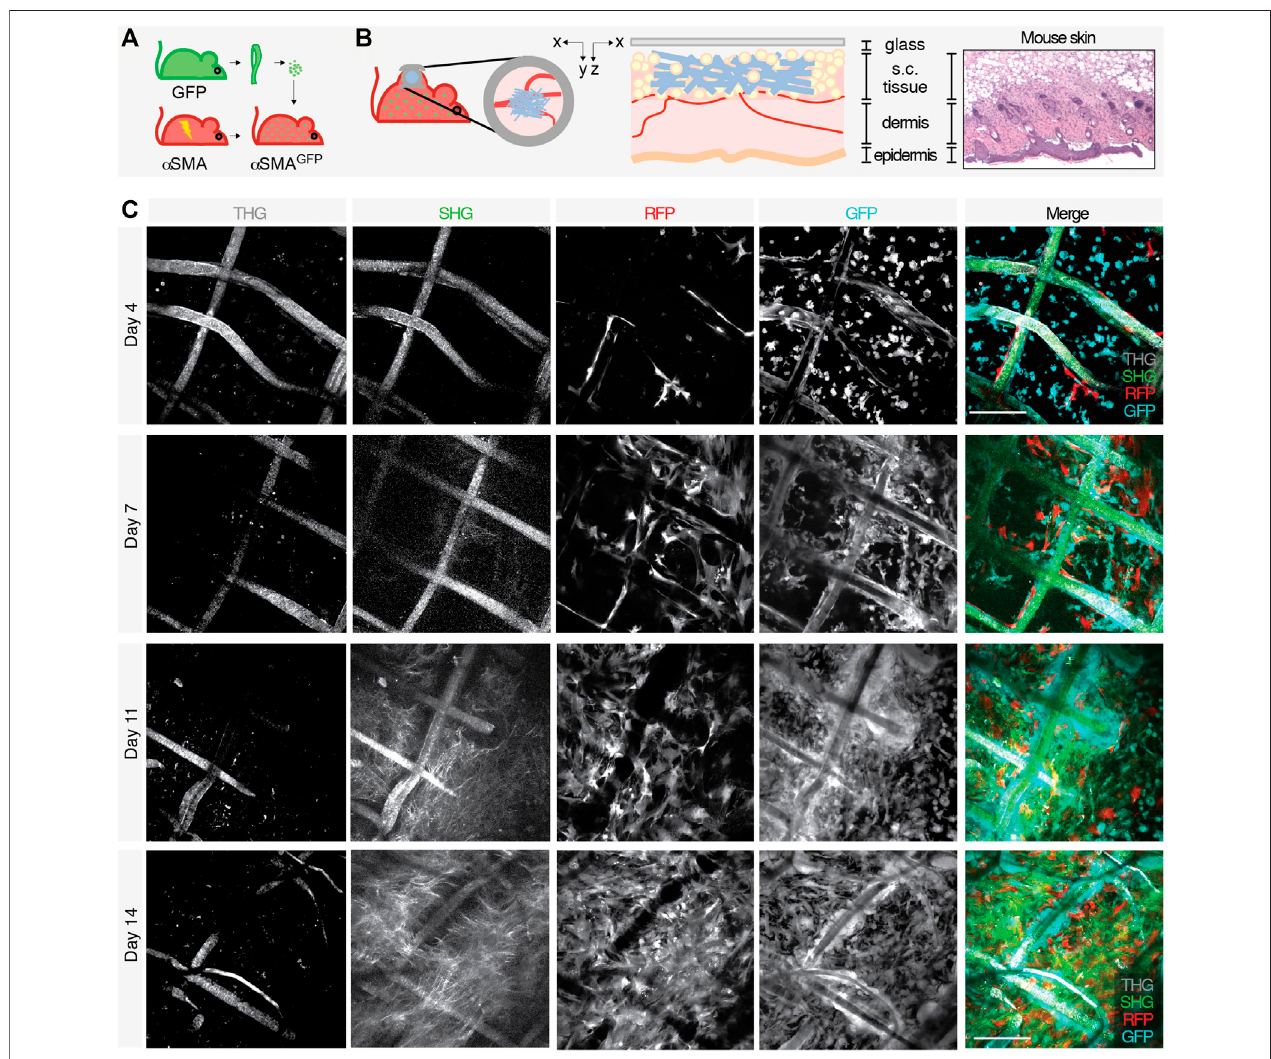
FIGURE2 | Generation ofan in vivo model to study the FBR and acquisition ofimages bylongitudinal intravital multiphoton microscopy. Schematic representation of the model showing (A) the bone marrow transplant in lethally irradiated α SMA-RFP mice reconstituted with GFP bone-derived cells to generate an α SMA-RFP/GFP mouse and (B) scaffold implantation inside the DSFC within the subcutaneous tissue, on top of the dermal layers (xy and xz projections of the implantation site are shown). Right panels show a scheme and the histology (H&E staining) of the mouse skin at the implantation site. (C) Longitudinal intravital imaging of the FBR elicited by the PCL scaffold. Single channels and merged pictures at days 4, 7, 11, and 14 post-implantation are shown. THG (gray); GFP-positive cells (cyan); RFP- positive cells (red), and SHG (green). Scale bar, 100 μ m.